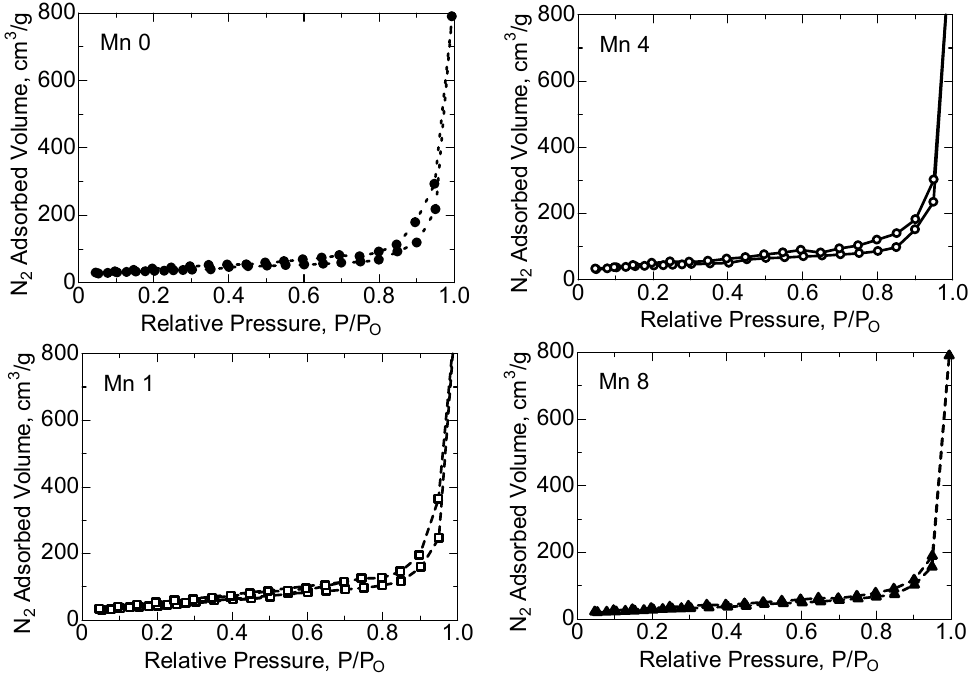
Figure 4. N 2 adsorption–desorption isotherms of samples with different contents of Mn synthesized in this work by hydrothermal method and calcined at 600 ◦ C for 5